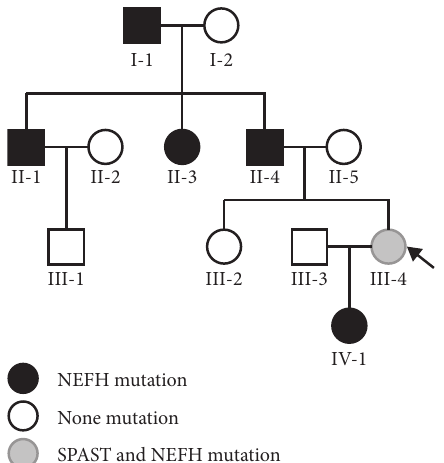
Figure 3: Pedigree of the patient’s family. The gray arrow indicates the proband II:5 of the SPASTand NEFH mutations. Squares indicate males, and circles indicate females. Individuals carrying the NEFH mutation are represented by black-filled symbols, whereas empty symbols indicate healthy individuals without the NEFH or SPASTmutation. The presence of the SPASTmutation alone was not observed in any family member.